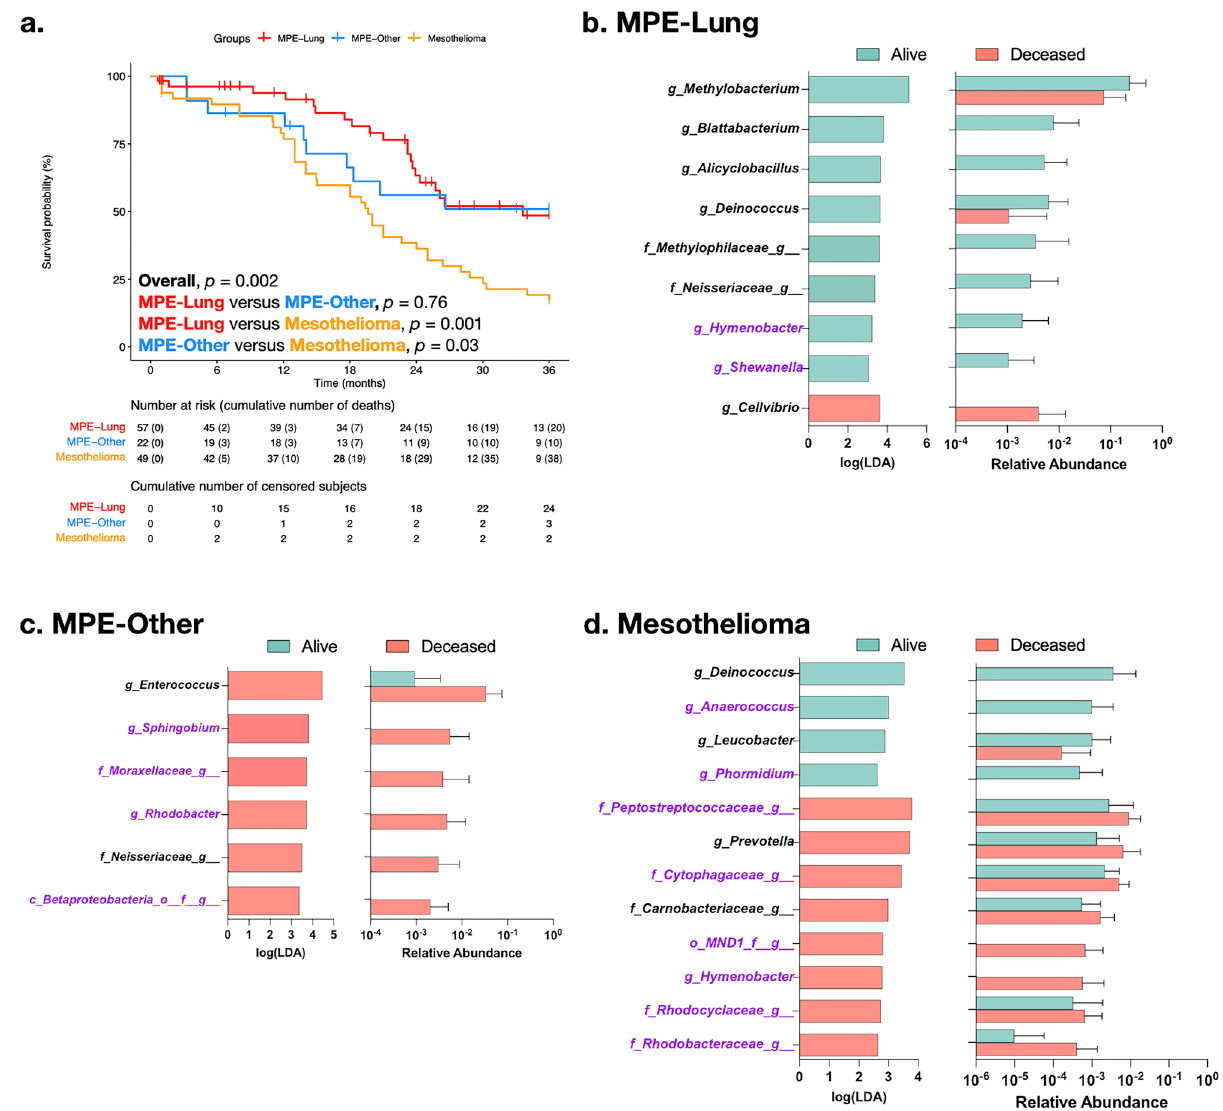
Figure 3. Taxonomic differences based on survival analysis. ( a ) Kaplan–Meier curves for groups of malignant pleural effusions. ( b ) Differential enrichment analysis by LEfSe for survival of subjects in the MPE-Lung group at time of median survival (33.6 months), MPE-Other group at time of median survival (36 months), and Mesothelioma group at time of median survival (19.6 months). Taxa colored in purple are potential